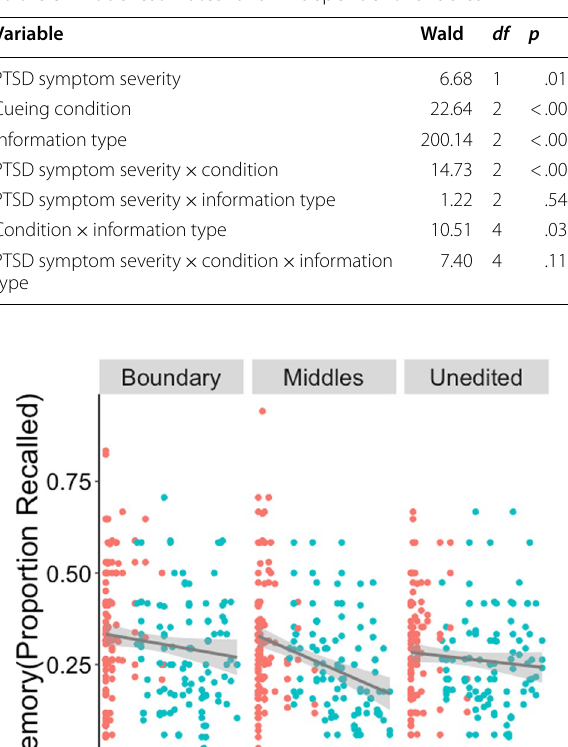
Table 3 Model estimates for all independent variables